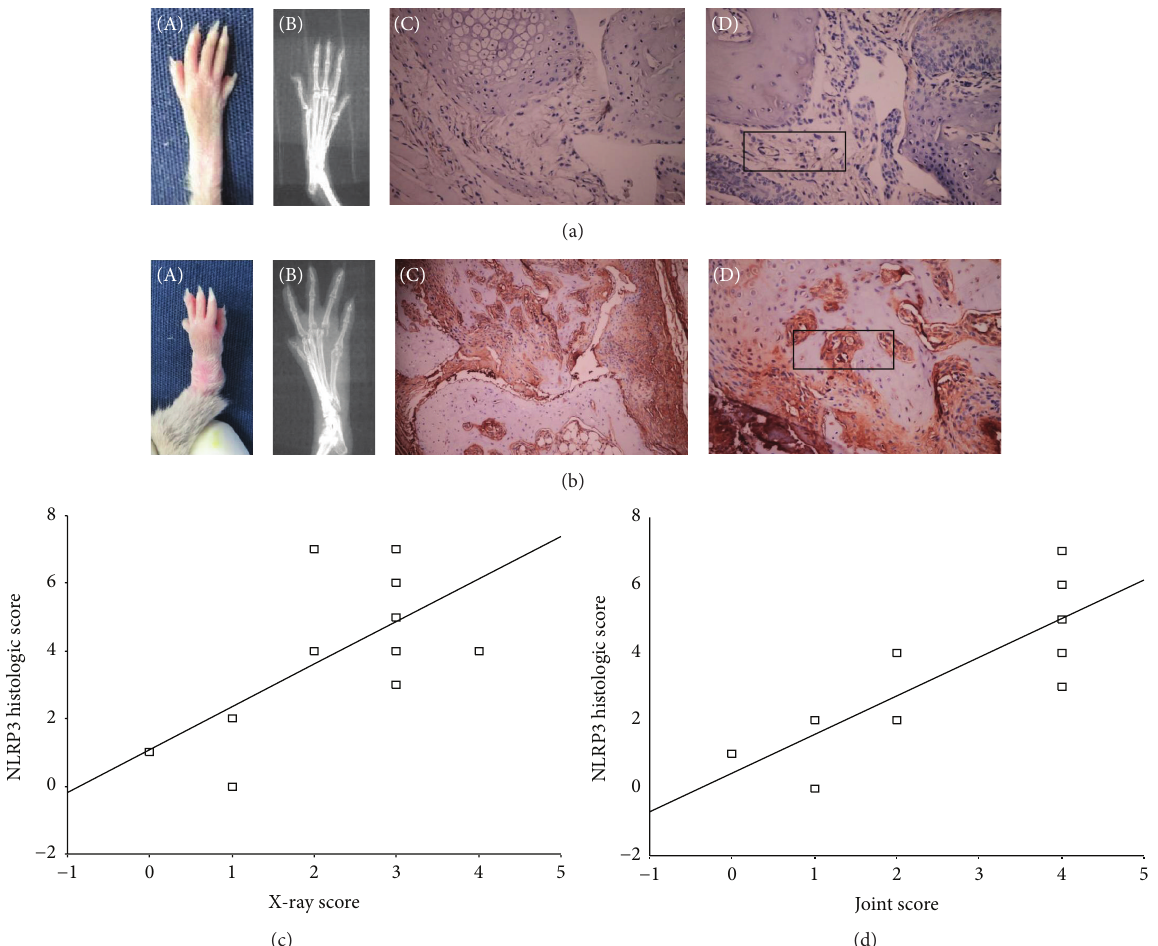
Figure 4: Synovial tissue NLRP3 expression and correlation analysis. (a) Normal mice. (A) No soft tissue swelling; (B) X-rays imaging showed no bone destruction and no joint space narrowing; (C, D) no significant synovial hyperplasia. (b) CIA mice. (A) Paw imaging showed significant articular soft tissue swelling; (B) X-rays showed the bone destruction and joint space narrowing at the proximal interphalangeal and metacarpophalangeal joint surfaceand visiblemetacarpophalangeal joint dislocation; (C)NLRP3 immunohistochemical stainingshowed significant NLRP3 expression at synovial proliferation areas and subchondral vasculitis areas; (D) square area showed increased NLRP3 expression in the synovial vascular endothelial cells that invaded the cartilage. (c) NLRP3 histology score and joint imaging score were positively correlated. (d) NLRP3 histology score and arthritis clinical score were positively correlated. Magnification ( ×